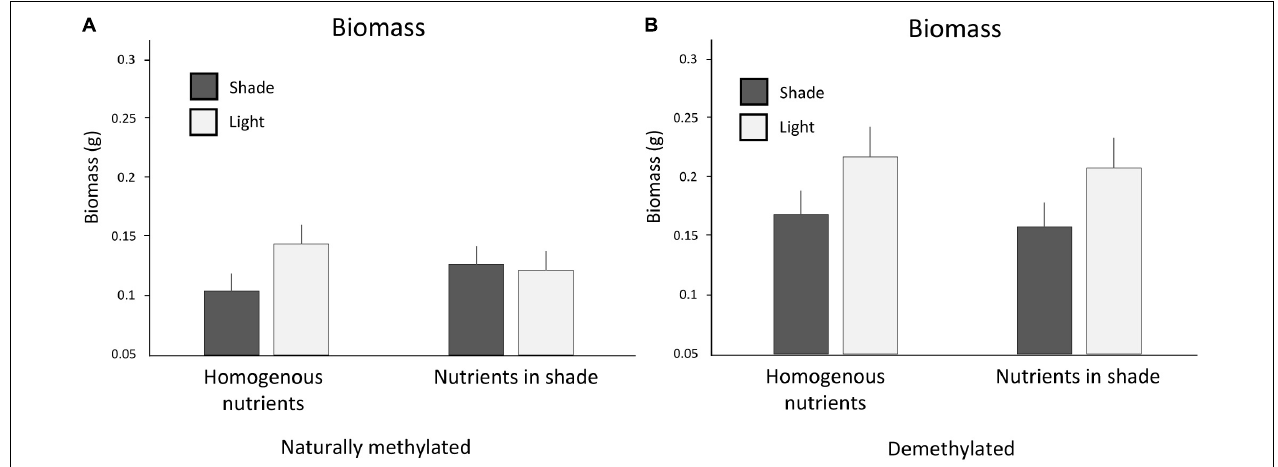
FIGURE 4 | Biomass production in the testing zone of clones (A) trained for nutrients in light or homogenously distributed nutrients and (B) naturally methylated and demethylated clones trained for nutrients to occur in shade or homogenously distributed nutrients. Means and SE are